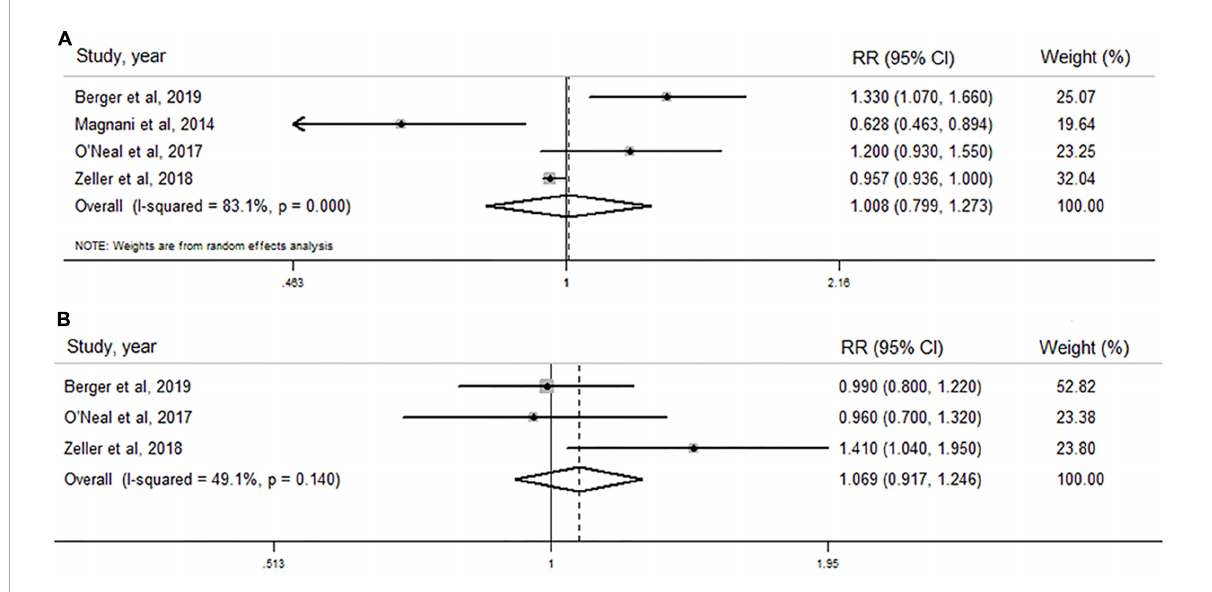
FIGURE2 Forest plots of the association between total testosterone level and risk of atrial fibrillation in men and post-menopausal women by pooling cohort studies. (A) The random-effect model was used to assess the association between total testosterone level and risk of atrial fibrillation in men; (B) fixed-effect model was used to assess the association between total testosterone level and risk of atrial fibrillation in post-menopausal